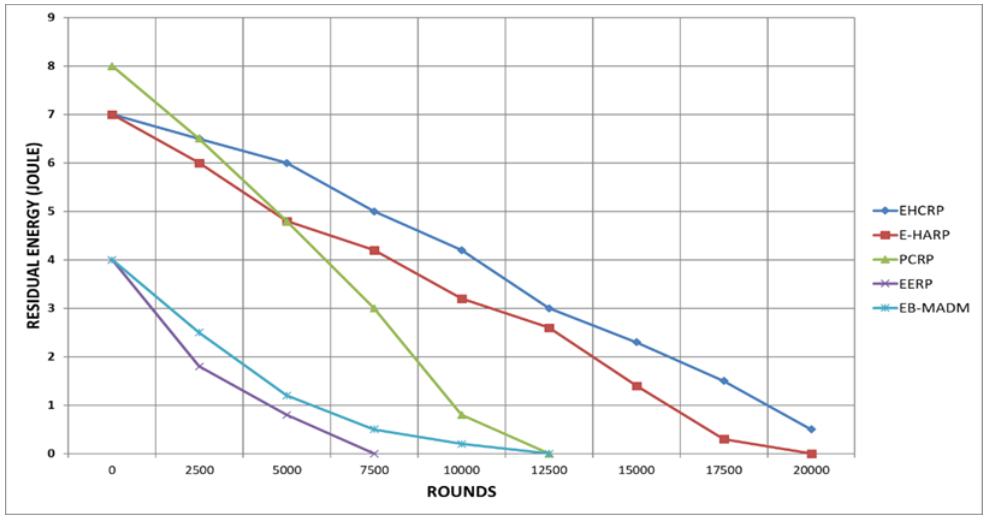
Figure 9. Breakdown of Energy Consumption. Table 6. Residual Energy vs. Time